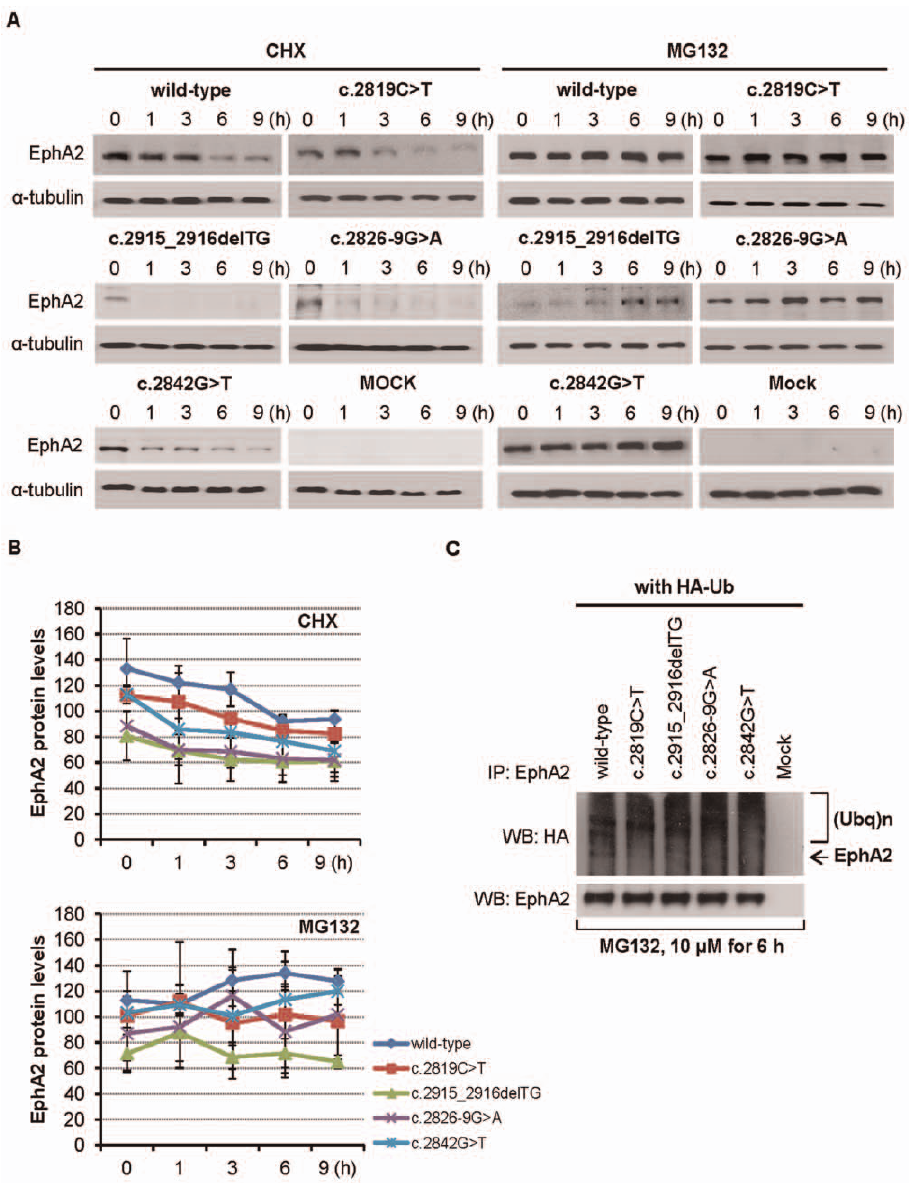
Figure 3. EPHA2 degradation is mediated by proteasomal pathway. ( A ) Mutant EPHA2 proteins have a reduced half-life. HEK293T cells were treated for indicated time with the protein biosynthesis inhibitor CHX (50 m g/mL) or the proteasome inhibitor MG132 (10 m M). Cell lysates were immunoblotted with anti-EphA2 antibody. Lysates were resolved by SDS-PAGE and western blot analysis was performed using indicated antibodies as described in the Materials and Methods. The blot was reprobed with anti- a -tubulin as a loading control. ( B ) Quantification of EphA2 protein levels over time. Mean values are presented with + S.D as indicated. ( C ) EPHA2 mutants have increased ubiquitination. Cells transfected with EPHA2 and HA-tagged ubiquitin were treated with 10 m M MG132 for 6 hours, and were then lysed. Immunoprecipitated EphA2 was further analyzed with western blotting using anti-HA antibodies to detect ubiquitinated EphA2 as described in the Materials and Methods. The smear band is characteristic ubiquitin immunoreactivity. The amount of total EphA2 is shown as a loading control.